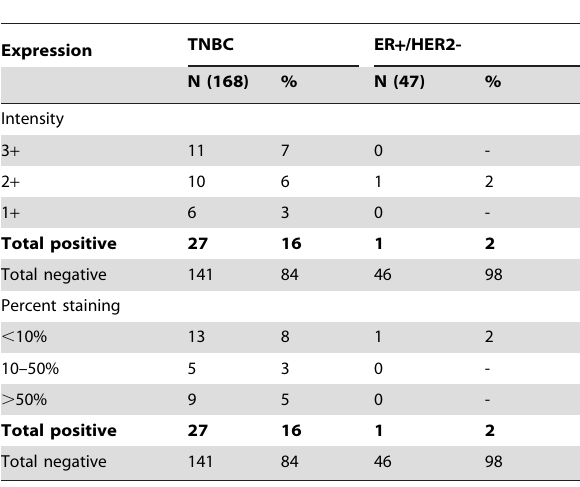
Table 2. NY-ESO-1 expression frequency by IHC.